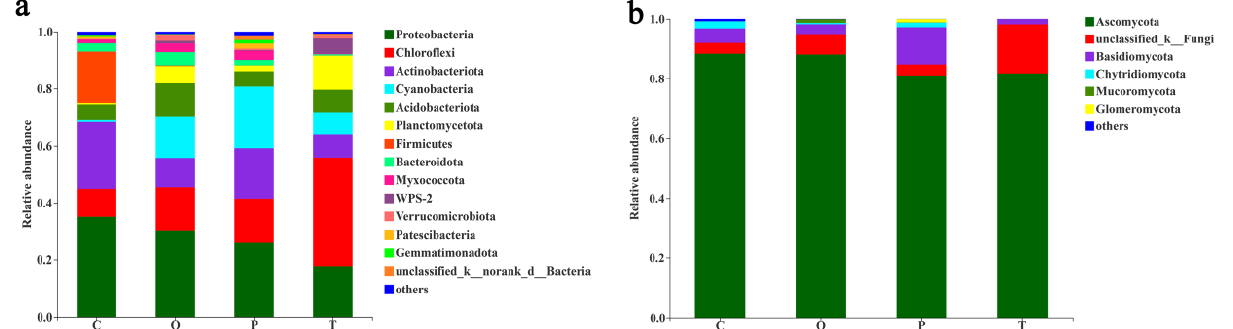
Figure 5. Relative abundance of the most abundant microbial phyla in moss-dominated biocrusts soils. Bar graphs of the relative abundance of the most abundant microbial phyla in the bacterial communities ( a ) and in the fungal communities ( b ) are shown. Only phyla with a total relative abundance higher than 1% are listed separately in the graphs, while less than 1% are reduced to others. C: Claopodium rugulosifolium ; O: Orthotrichum courtoisii ; P: Polytrichum formosum ; T: Taxiphyl- lum giraldii .